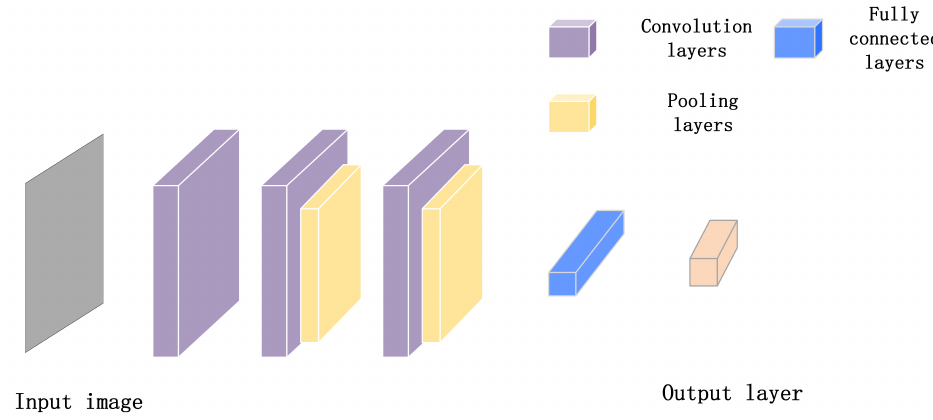
Figure 1. Building blocks of a